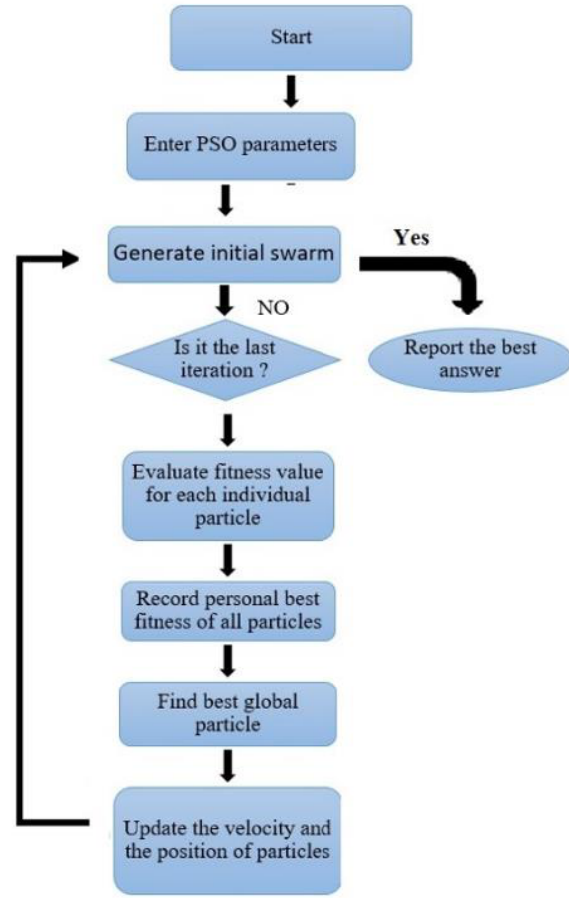
Figure 16. PSO sequential flowchart [57].